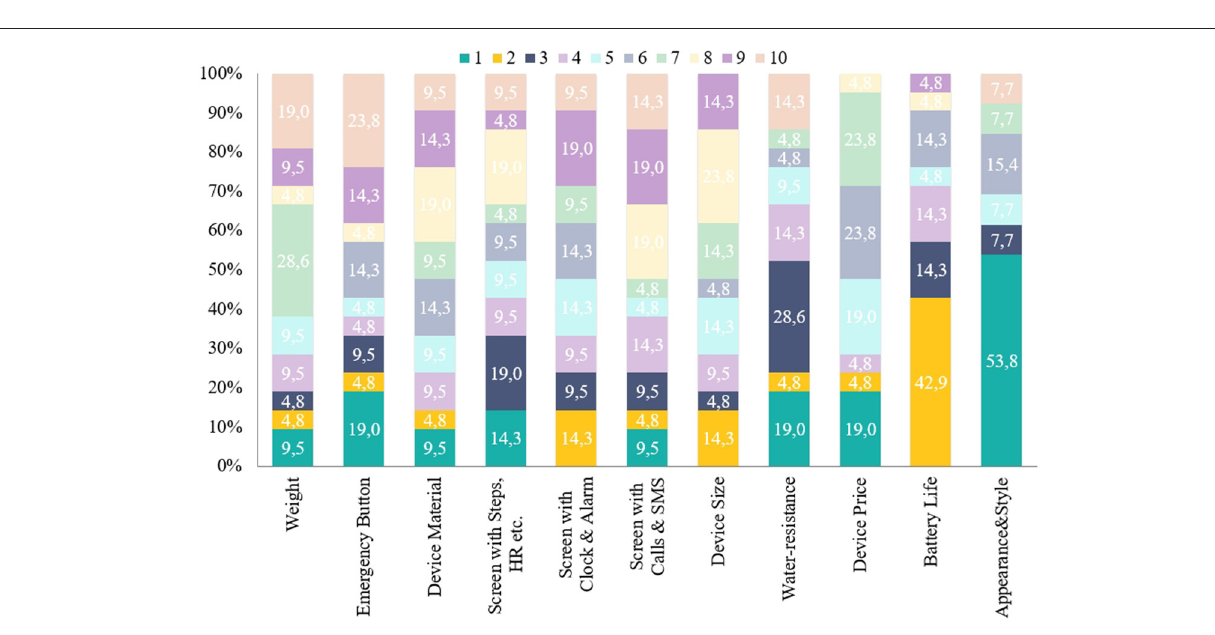
FIGURE 8 | Preferred order of Metrics: percentage of members of the PAB that placed the metric in each place from 1 to 10 (most to least preferred).